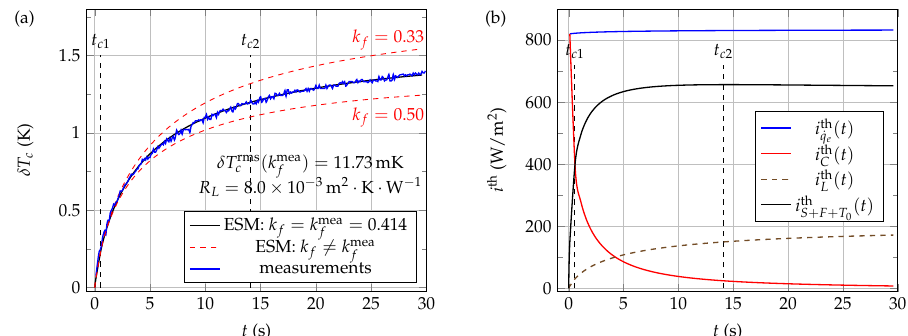
Figure 21. Experimental and 1D ESM computed thermal signals in the case of water–glycerol mixture 50W50G at rest. These signals were obtained using a voltage step excitation v 0 = 8.39V at a working temperature T 0 = 22.0 ◦ C and immersion length L i = 0.0mm: ( a ) measurements and ESM results;